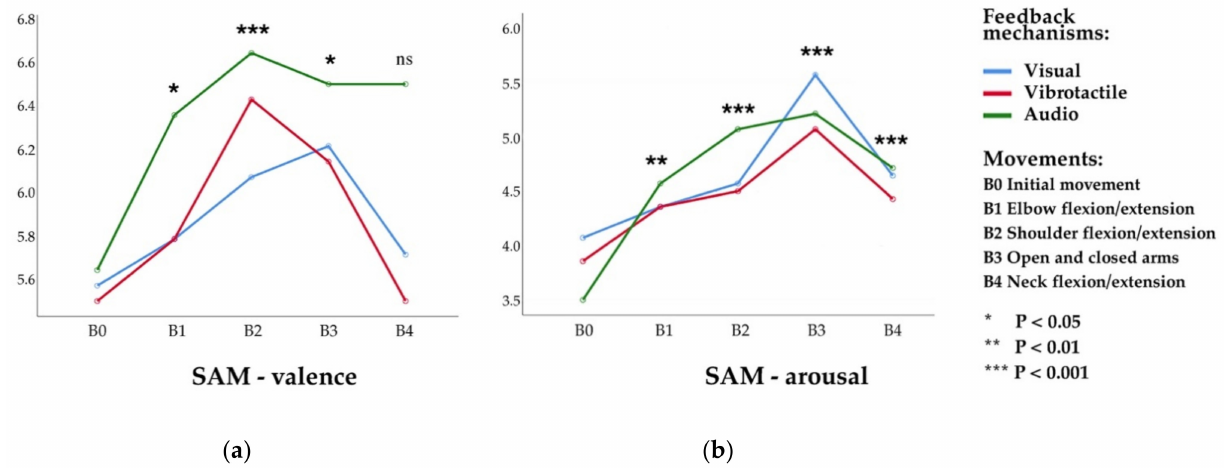
Figure 8. Estimated Marginal Means of SAM questionnaire data when participants perform under different movements and feedback mechanisms. ( a ) SAM valence—the intrinsic positive or negative valence of their emotional feelings; and ( b ) SAM arousal—the emotional state of being